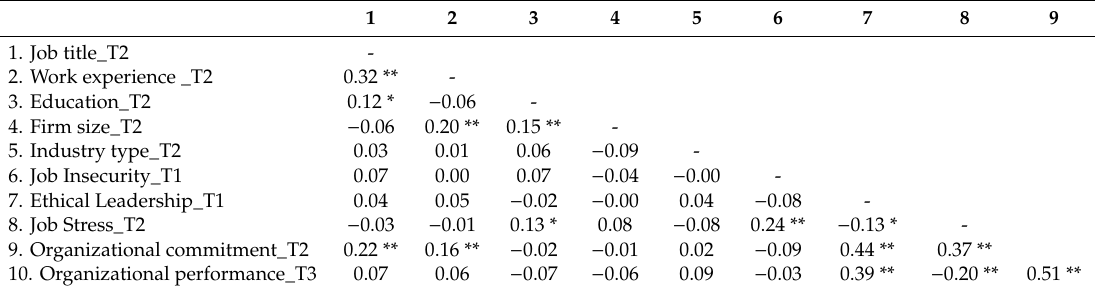
Table 2. Descriptive